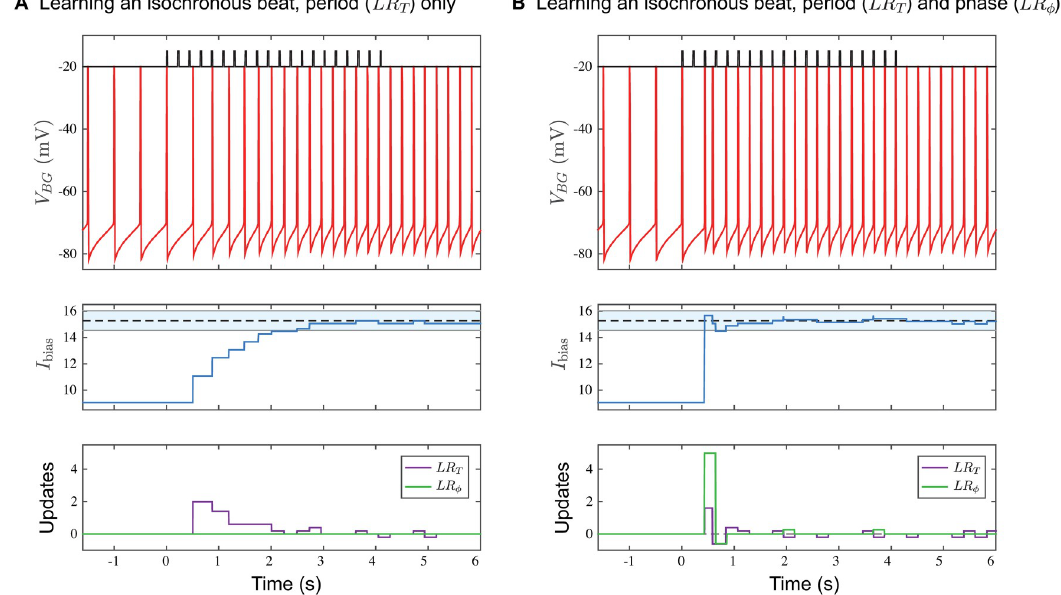
Fig 3. Effect of learning rules. A . Period Matching with LR . The voltage time course (top) of the BG is shown under three different T conditions; i) Endogenously oscillating at 2 Hz with no stimulus and no learning rule from t = − 1.5 to 0 s; ii) Learning the 4.65 Hz isochronous period in the presence of the stimulus from t = 0 to 4.2 s; iii) Performing synchronization continuation once the stimulus is removed at t = 4.2 s. I bias changes on a cycle-by-cycle basis (middle panel). Around t = 2.25 s, I bias enters the shaded blue regime (14.54, 16.03) that represents the one gamma cycle accuracy range from the 15.27 value that produces exactly 4.65 Hz. After t = 2.75 s, I bias lies very close to the correct value. Updates to I bias rely solely on LR T , the period learning rule (lower panel). B . Period and phase matching with both